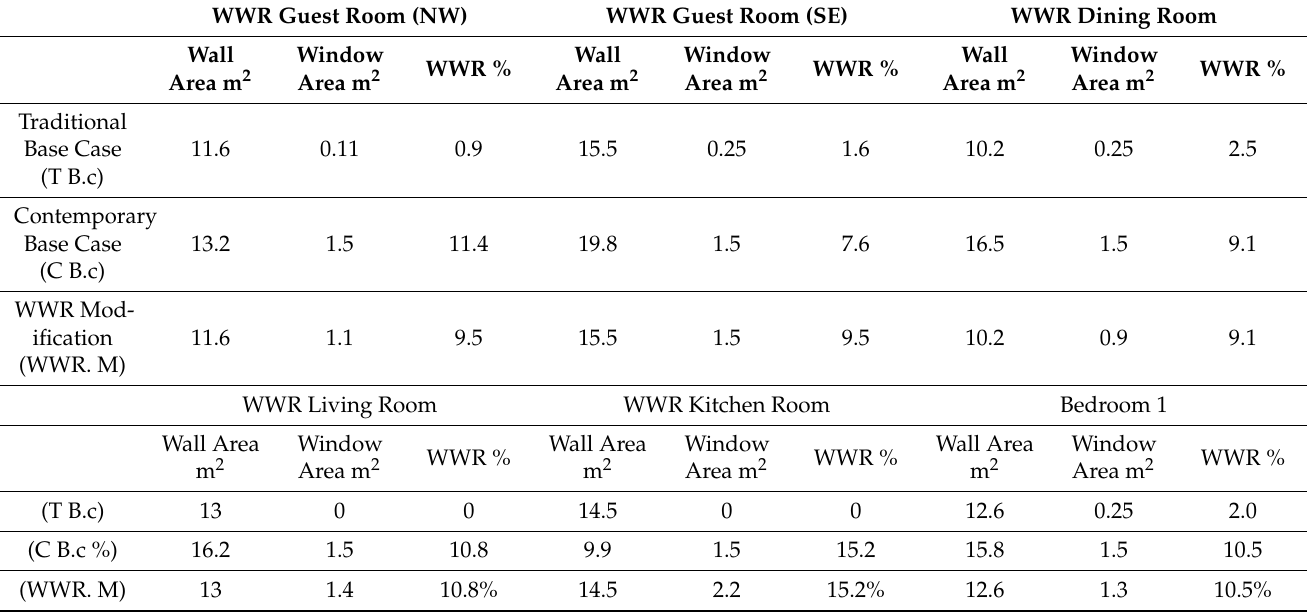
Table 2. The modification of WWR in traditional house in Riyadh city Case